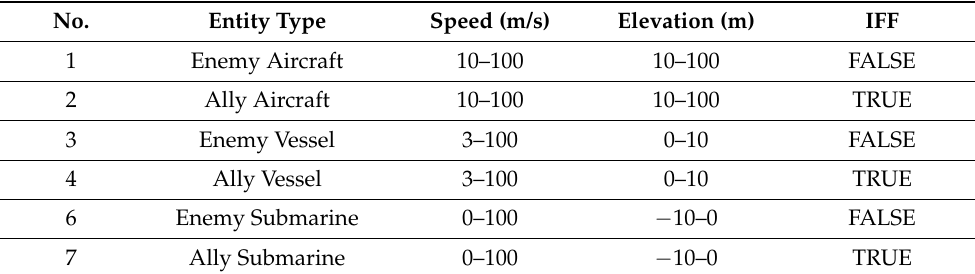
Table 3. Speed, altitude, and IFF ranges of target objects.